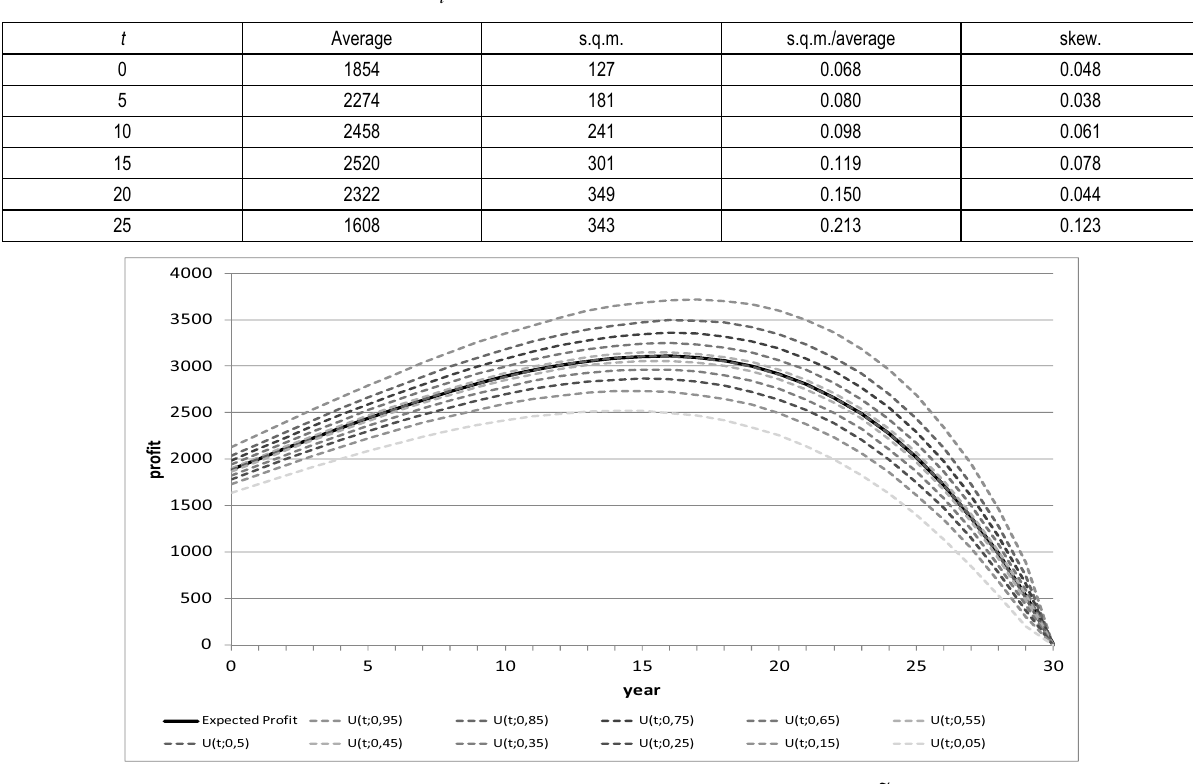
(cid:5) U evidenced for the standard stochasticity level, with contract escapes t